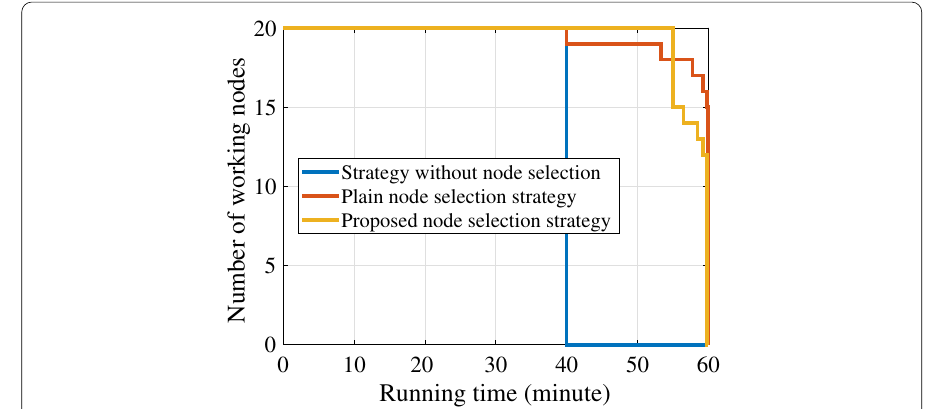
Fig. 20 Performance of intermediate node selection